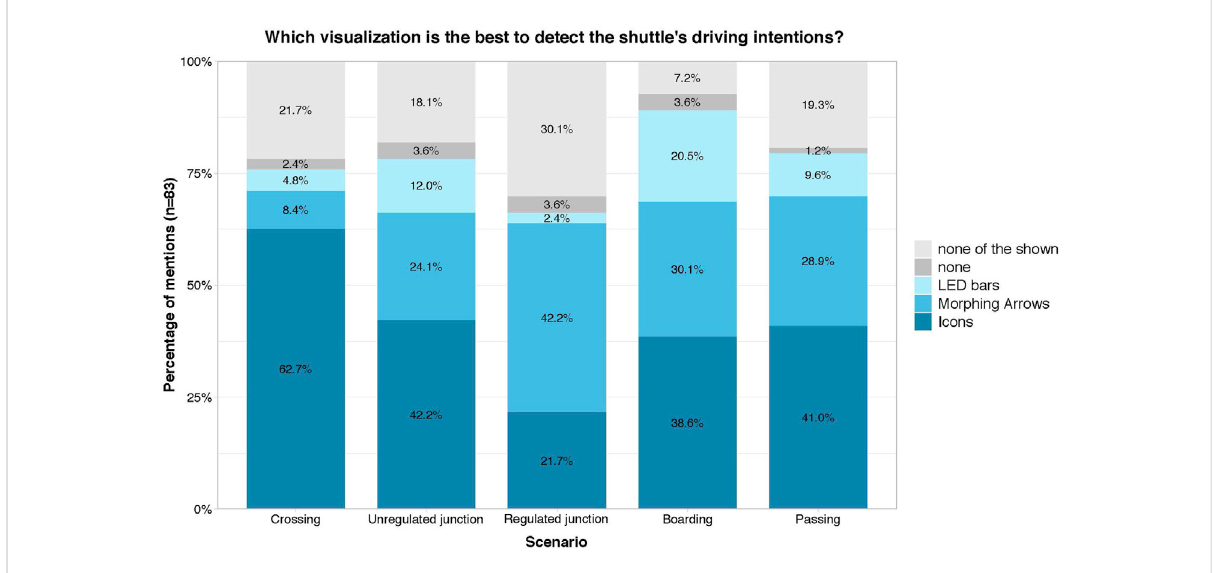
FIGURE 9 Preferred eHMI for detecting the shuttle ’ s